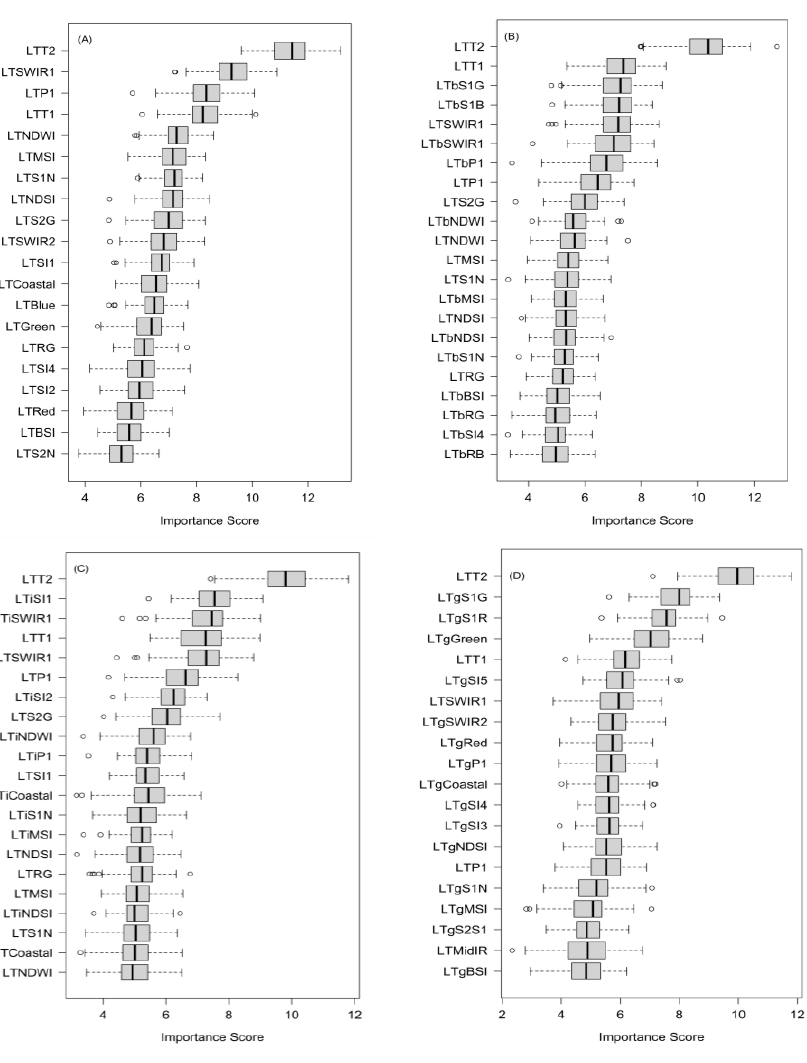
Figure 2. Importance scores of Landsat-8-based spectral indices identified as predictors in ( A ) Landsat-8 model; ( B ) Brovey Landsat-8 model; ( C ) IHS Landsat-8 model; ( D ) GS Landsat-8 model.